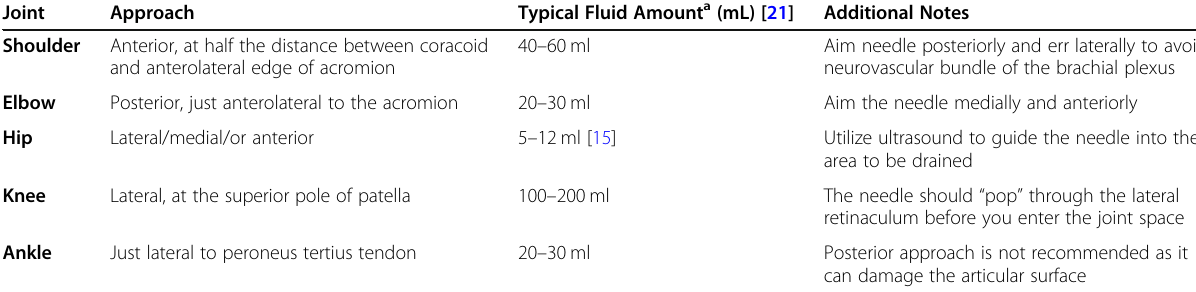
Table 4 Characteristics of Common Joint Aspirations Joint Approach Typical Fluid Amount a (mL)